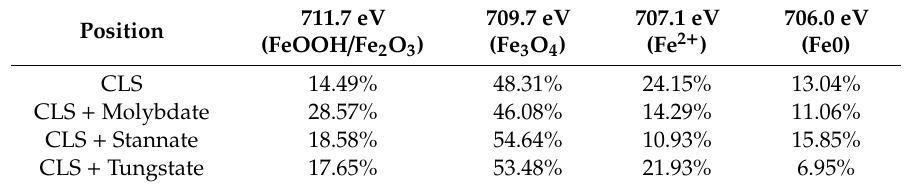
Table 1. The components of Fe in the surface film of inhibitor treated steel. CLS, calcium lignosulfonate. 711.7 Position